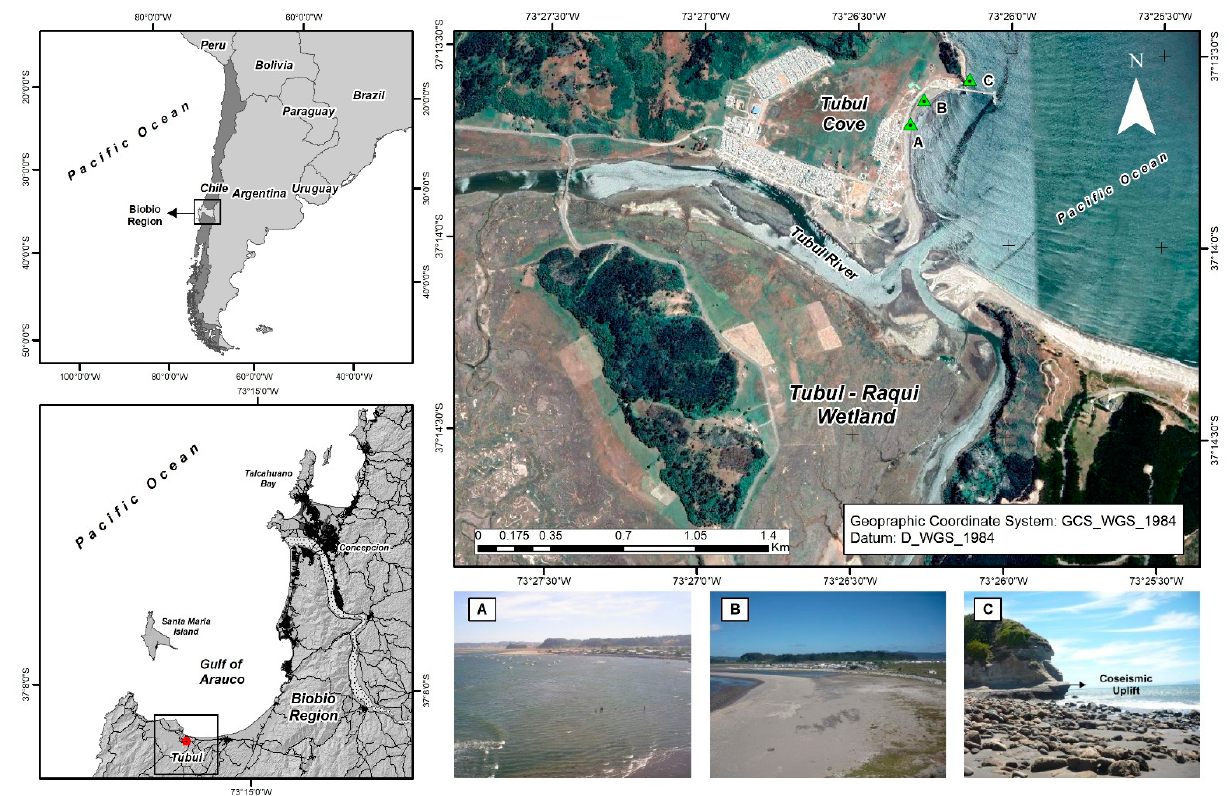
Figure 1. Study area. The figure on the left shows the context of the location of the Tubul-Raqui wetland on the interior of the Gulf of Arauco, on the south-central Chilean coast: ( A ) (view from point A to E), ( B ) (view from point B to SE), and ( C ) (view from river mouth to point C toward NW) show pre- and postearthquake morphological changes, indicating their location on the coastal area of the wetland; ( A ) shows the marine zone next off Tubul Cove in pre-earthquake conditions, which is now an intertidal zone of Tubul Beach due to coastal uplift produced by the earthquake. Here, a beach approximately 100 m wide was formed ( B ); ( C ) shows the marine abrasion platform that emerged due to coastal uplift measured at 1.4 m by Quezada [44] after the 2010 earthquake.